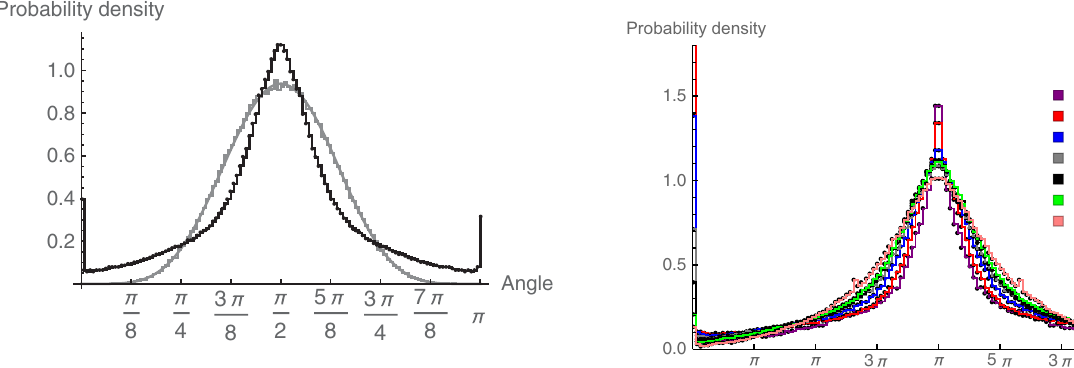
FIG. 14. The probability distribution for the angles between ¼ 6 (black) compared branch vectors in random origami with V i to randomly distributed points on a six-dimensional sphere FIG. 15. The probability distribution that any two pairs of (gray). The bin sizes are π = 32 . The solid gray line is an analytical branches will be a given angle apart for random origami with V ¼ 2 – 8 vertices. The bin sizes are π = 32 prediction using Eq. (5) of Ref. [39].